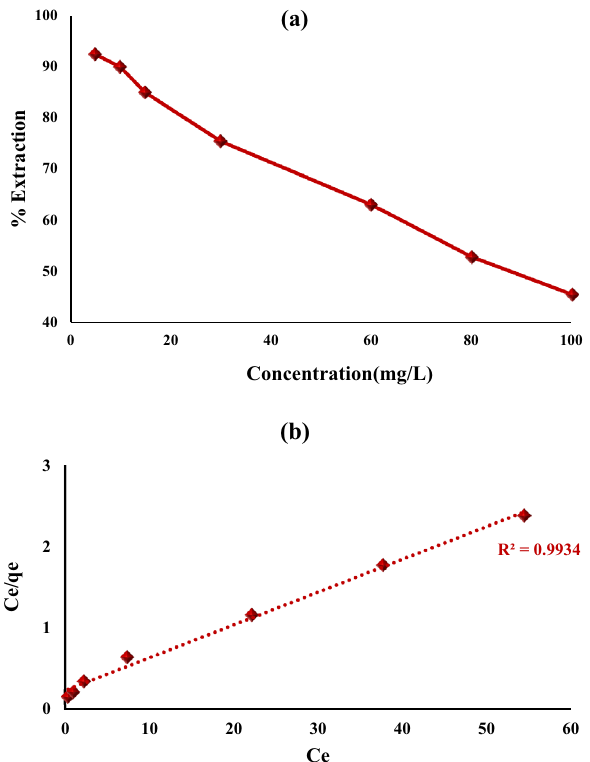
Figure 10. ( a ) Impact of initial concentration on Cr(IV) ions removal by Fe 0.75 Cu 0.25 -BDC@Alg-MoO 3 /GO and ( b ) Langmuir model.